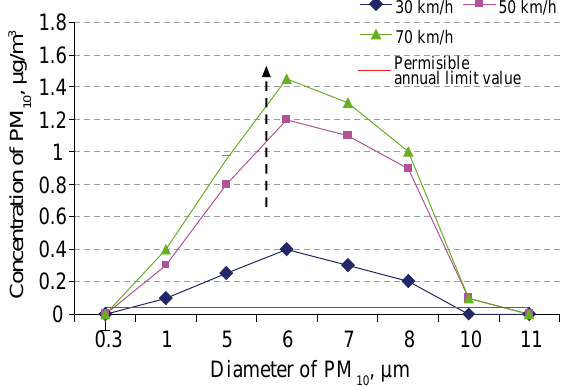
Fig. 3. Dependency of PM 10 emissions on particle diameter, when a passenger car moves at a 30, 50 and 70 km/h speed by Gustafsson et al. 2008